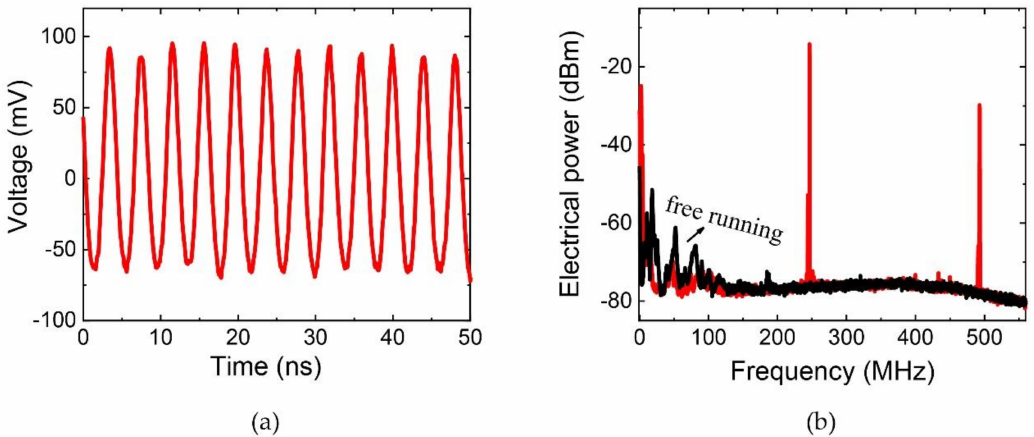
Figure 2. ( a ) Temporal waveform and ( b ) electrical spectrum of the P1 oscillation at 300 mA. The tilt angle of the reflector is − 1.05 (cid:48)